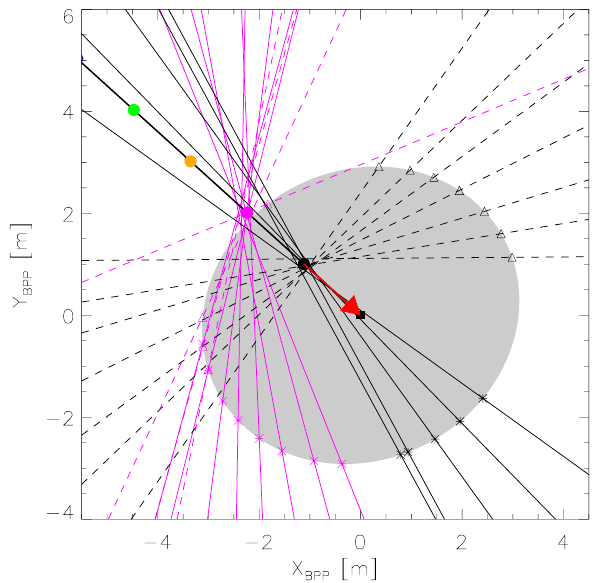
Fig. 4. Example of the triangulation analysis. The figure shows the spacecraft, the guns and the beam firing directions, all projected into the B ⊥ -plane, for a 4s interval on 5 March 2001 (see Fig. 12). Gun1 and Gun2 locations are indicated by asterisks and triangles, respectively, the beams emanating from these guns are shown as dashed and solid lines, respectively. The solid circles are placed at integer multiples of the drift step from the center of the space- craft, and are obtained from the best fit to all the beams in this in- terval. The (red) vector from the solid black circle to the center of the spacecraft is the drift step. The correct identification of the magenta-colored beams as double runners obviously has a profound effect on the drift step, identified by the black circle, which is the target for the single runners (black beams). No higher-order runners are present in this case. The drift step is 1.5m in this